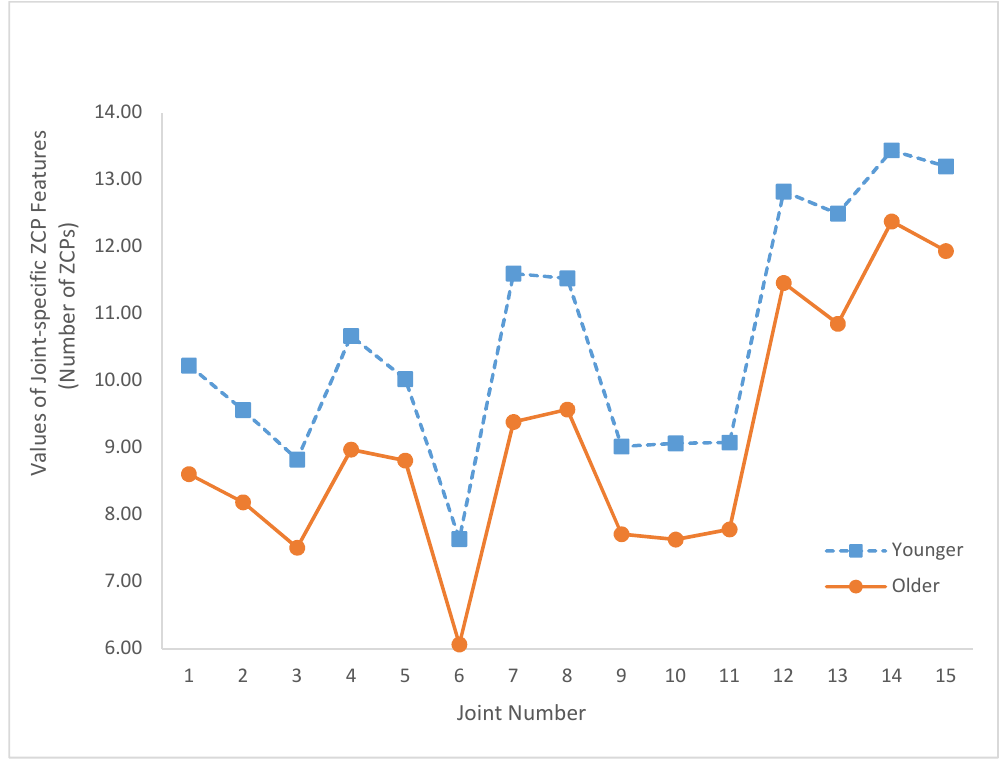
Figure 6. Summary of the joint-specific zero-crossing point (ZCP) features (JZCP i , i = 1, ... , 15) for both age